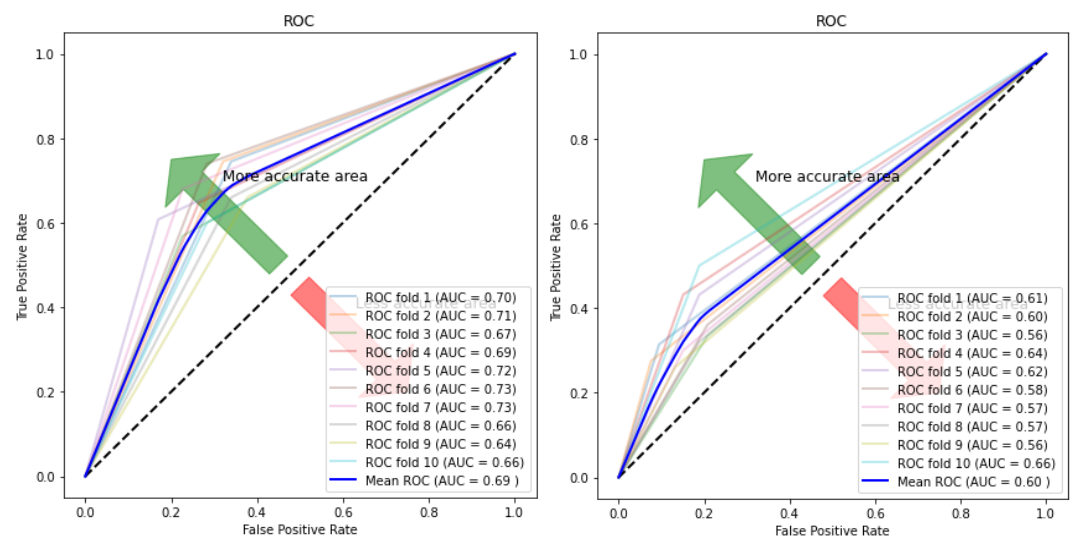
Children 2020 , 7 , x FOR PEER REVIEW Figure 15. ROC curve and AUC values for autoencoder–SVM ( Left ) and SVM ( Right ).